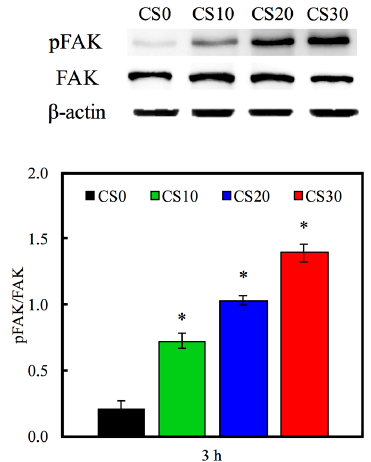
Figure 8. Western blotting of pFAK protein expression of hMSCs cultured on various specimens for 3 h. “*” indicates a significant difference ( p < 0.05) compared to CS0.